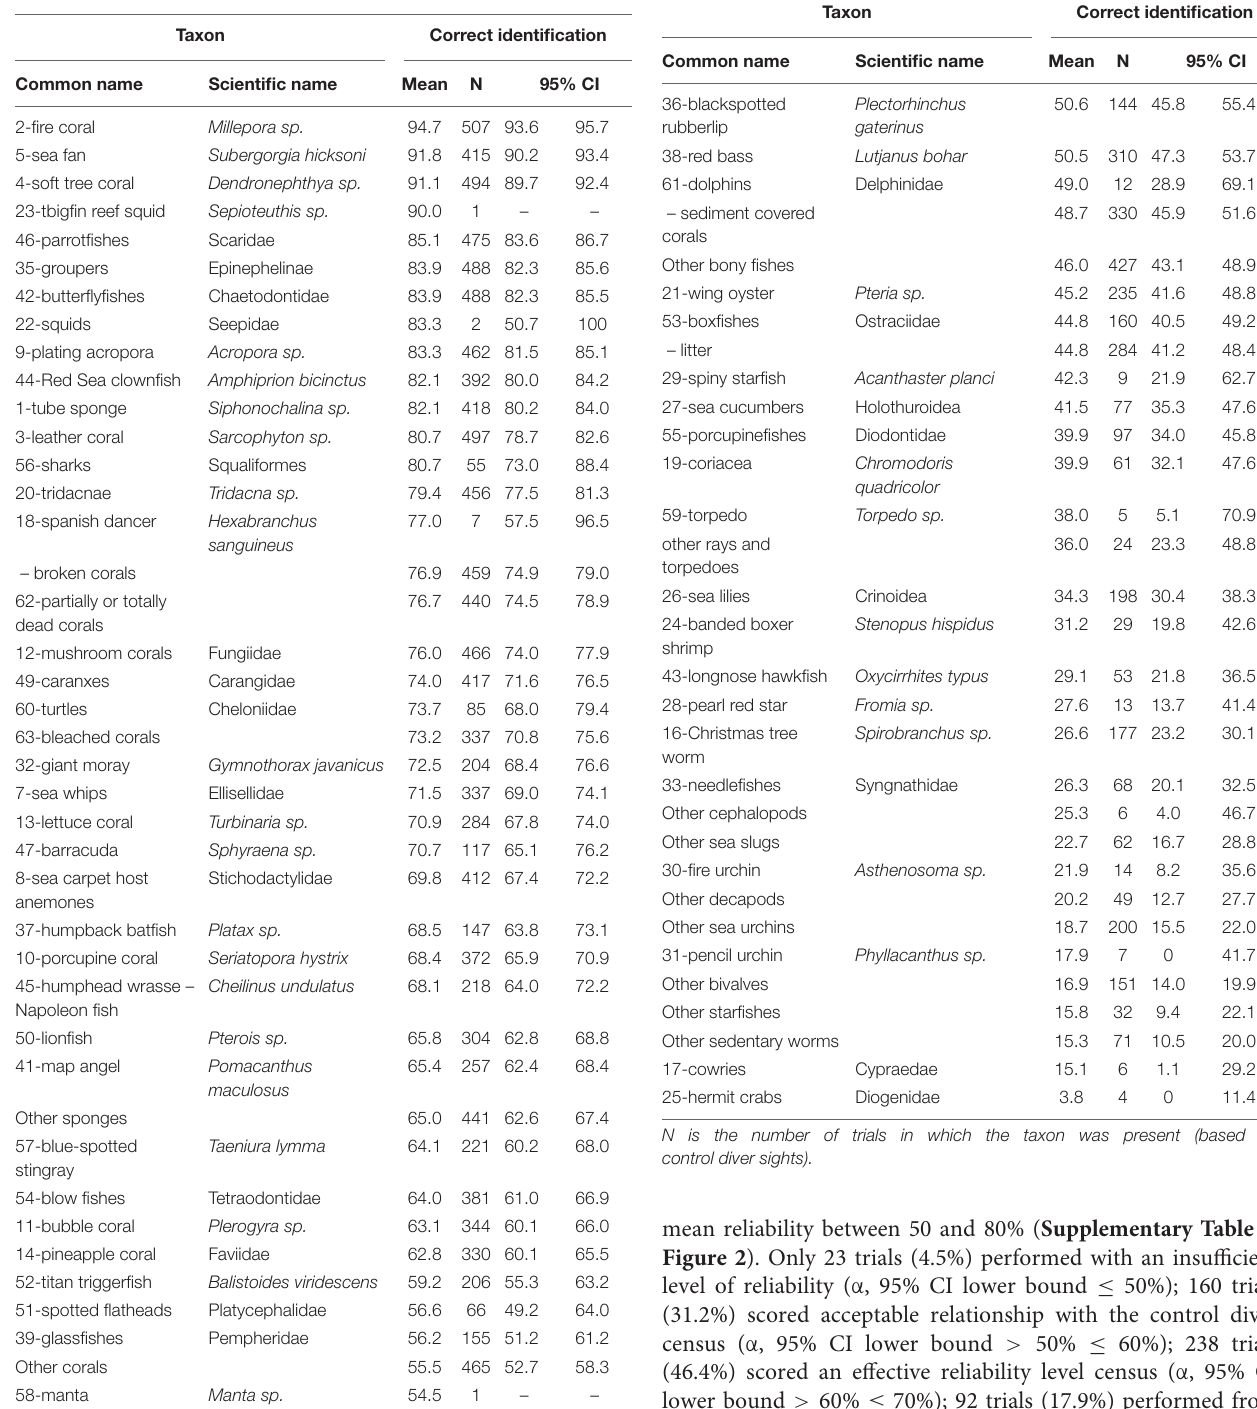
mean reliability between 50 and 80% ( Supplementary Table 1 ; Figure 2 ). Only 23 trials (4.5%) performed with an insufficient level of reliability ( α , 95% CI lower bound ≤ 50%); 160 trials (31.2%) scored acceptable relationship with the control diver census ( α , 95% CI lower bound > 50% ≤ 60%); 238 trials (46.4%) scored an effective reliability level census ( α , 95% CI lower bound > 60% ≤ 70%); 92 trials (17.9%) performed from definitive to very high levels of reliability census ( α , 95% CI lower bound > 70% ≤ 100%). Reliability was positively correlated with: team size ( ρ s = 0.212, N = 513, p < 0.001, Table 2 ; Figure 3 ), volunteers scores increased with number of present divers, with a score increase of 12.4% between small and big groups ( Table 3 ); volunteer diving certification level ( ρ s = 0.200, N = 513, p <